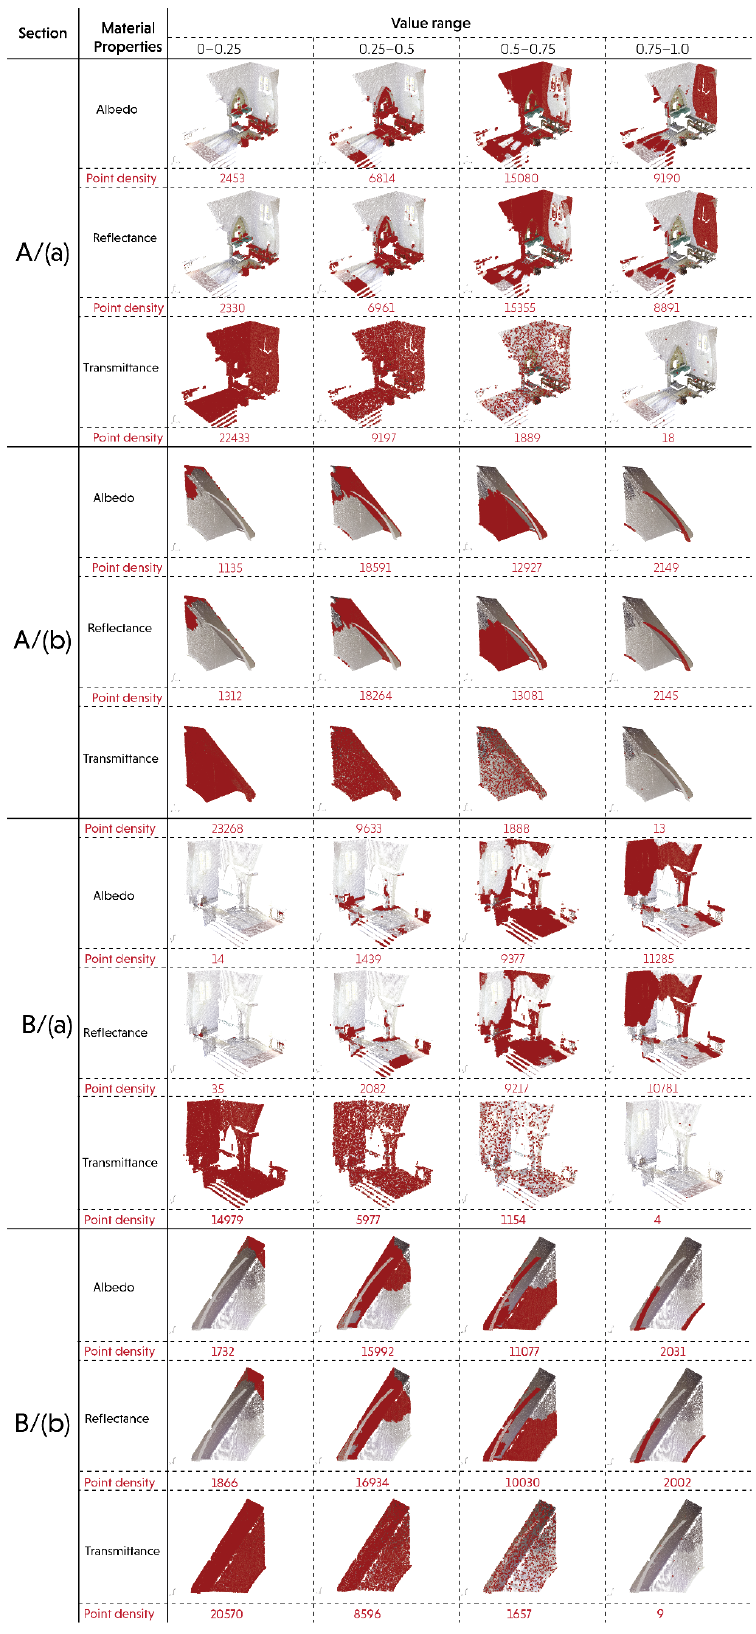
Figure 6. Surface distribution of material properties. A /( a ) Fracture zone–North wall; A /( b ) Fracture zone–North roof; B /( a ) Fracture zone–South wall; B /( b ) Fracture zone–South